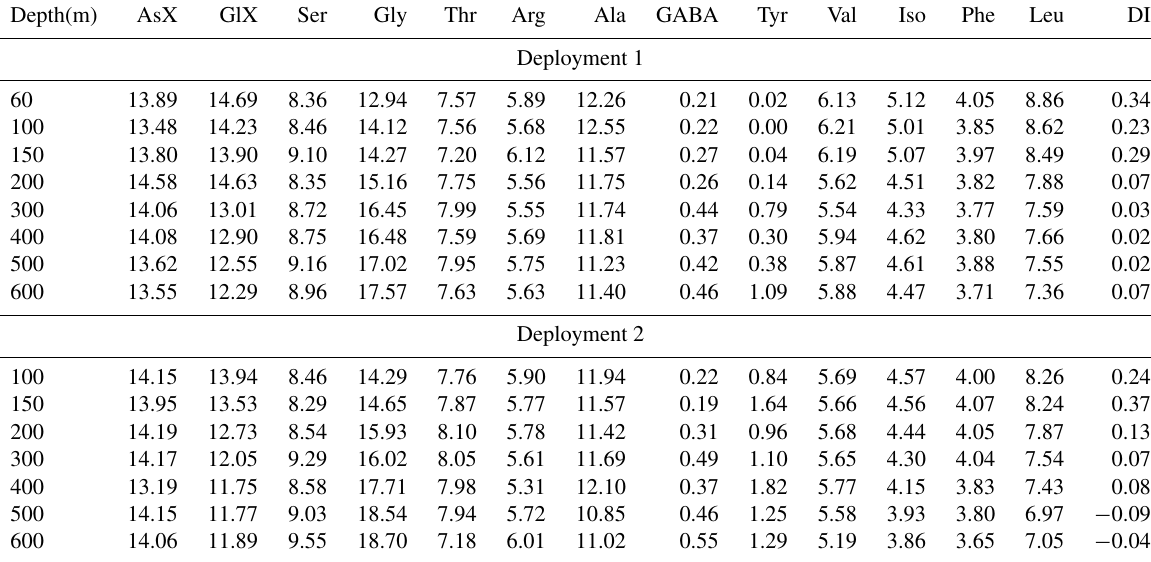
Table 2. Composition (%Mol) and degradation index (DI) of PHAA collected at different depths during two trap deployments (1 and 2) in the ETNA